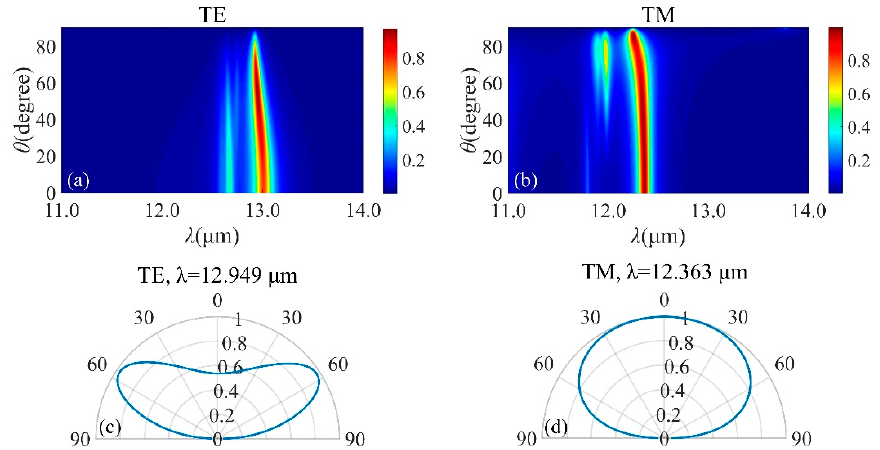
Figure 9. Emission spectra of SiC gratings − based structure with 5 DBR pairs when p = 2 μ m, f = 0.5 and d g = 0.7 μ m for TE − ( a ) and TM − ( b ) polarization. Angle distributions of the emission at λ = 12.949 μ m and λ = 12.363 μ m are shown for TE − ( c ) and TM − ( d ) polarizations, respectively.